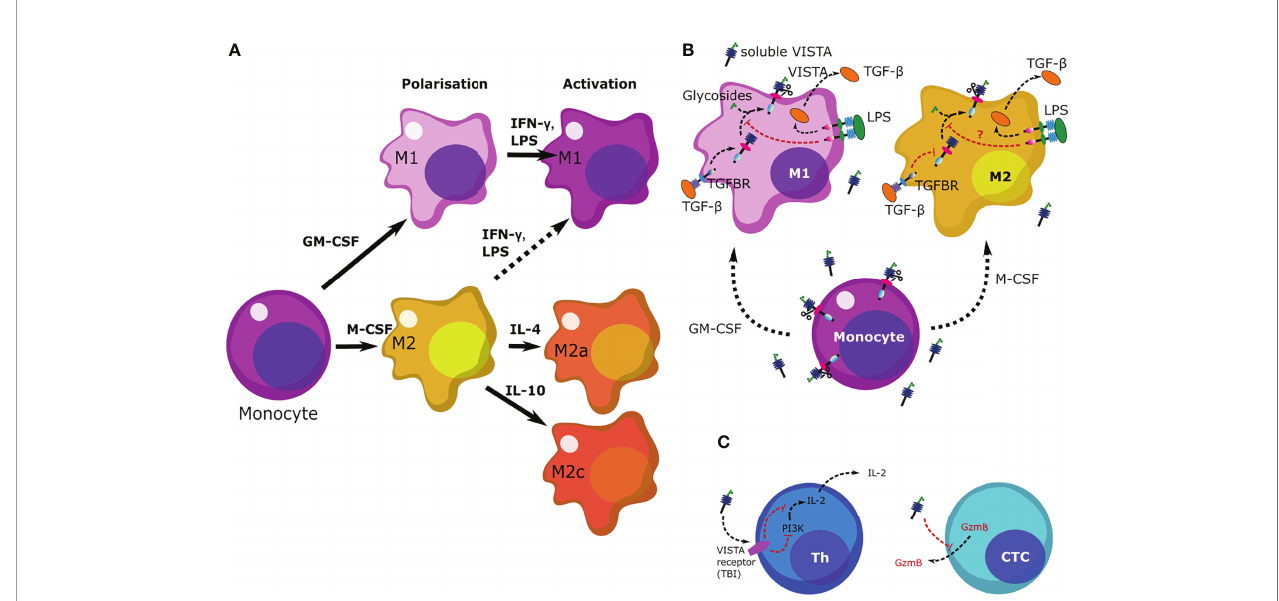
FIGURE 8 | Scheme summarizing the regulation of VISTA levels in M1 and M2 macrophages as well as the role of VISTA in immune responses. (A) Differentiation and polarization of monocytes to macrophages in response to various stimuli. (B) Monocytes release higher levels of VISTA than macrophages. Upon differentiation, release of soluble VISTA is downregulated given the function of macrophages. Presence of LPS upregulates TGF- b production in both types of macrophages (M1 and M2), although M2 macrophages release more TGF- b , in accordance with their immunosuppressive role. M1 macrophages respond by upregulation of VISTA expression in response to exposure to LPS, an effect which could be triggered by TGF- b (21). However, VISTA release is downregulated. The purpose of such a response in a pathophysiological environment would trigger re-activation of the immune response in the presence of LPS. Downregulation of VISTA in this case is very likely a differential type of response to TGF- b , as reported recently. (21) (C) soluble VISTA acts on T cells through a receptor which remains to be identi fi ed (TBI) leading to downregulation of PI3K activity in T helper cells (Th) thus leading to decreased IL-2 production. In cytotoxic T cells (CTCs) VISTA downregulates the release of granzyme B, subsequently blocking their cytotoxic